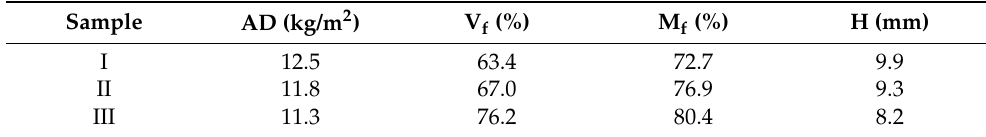
Figure 3. Details of specimen preparation: ( a – c ) pressure equipment and mold; ( d ) curing process of two-component polyurethane resin system; ( e ) cutting scheme; ( f ) manufactured sample; ( g ) cut sample. Table 3. Specifications of